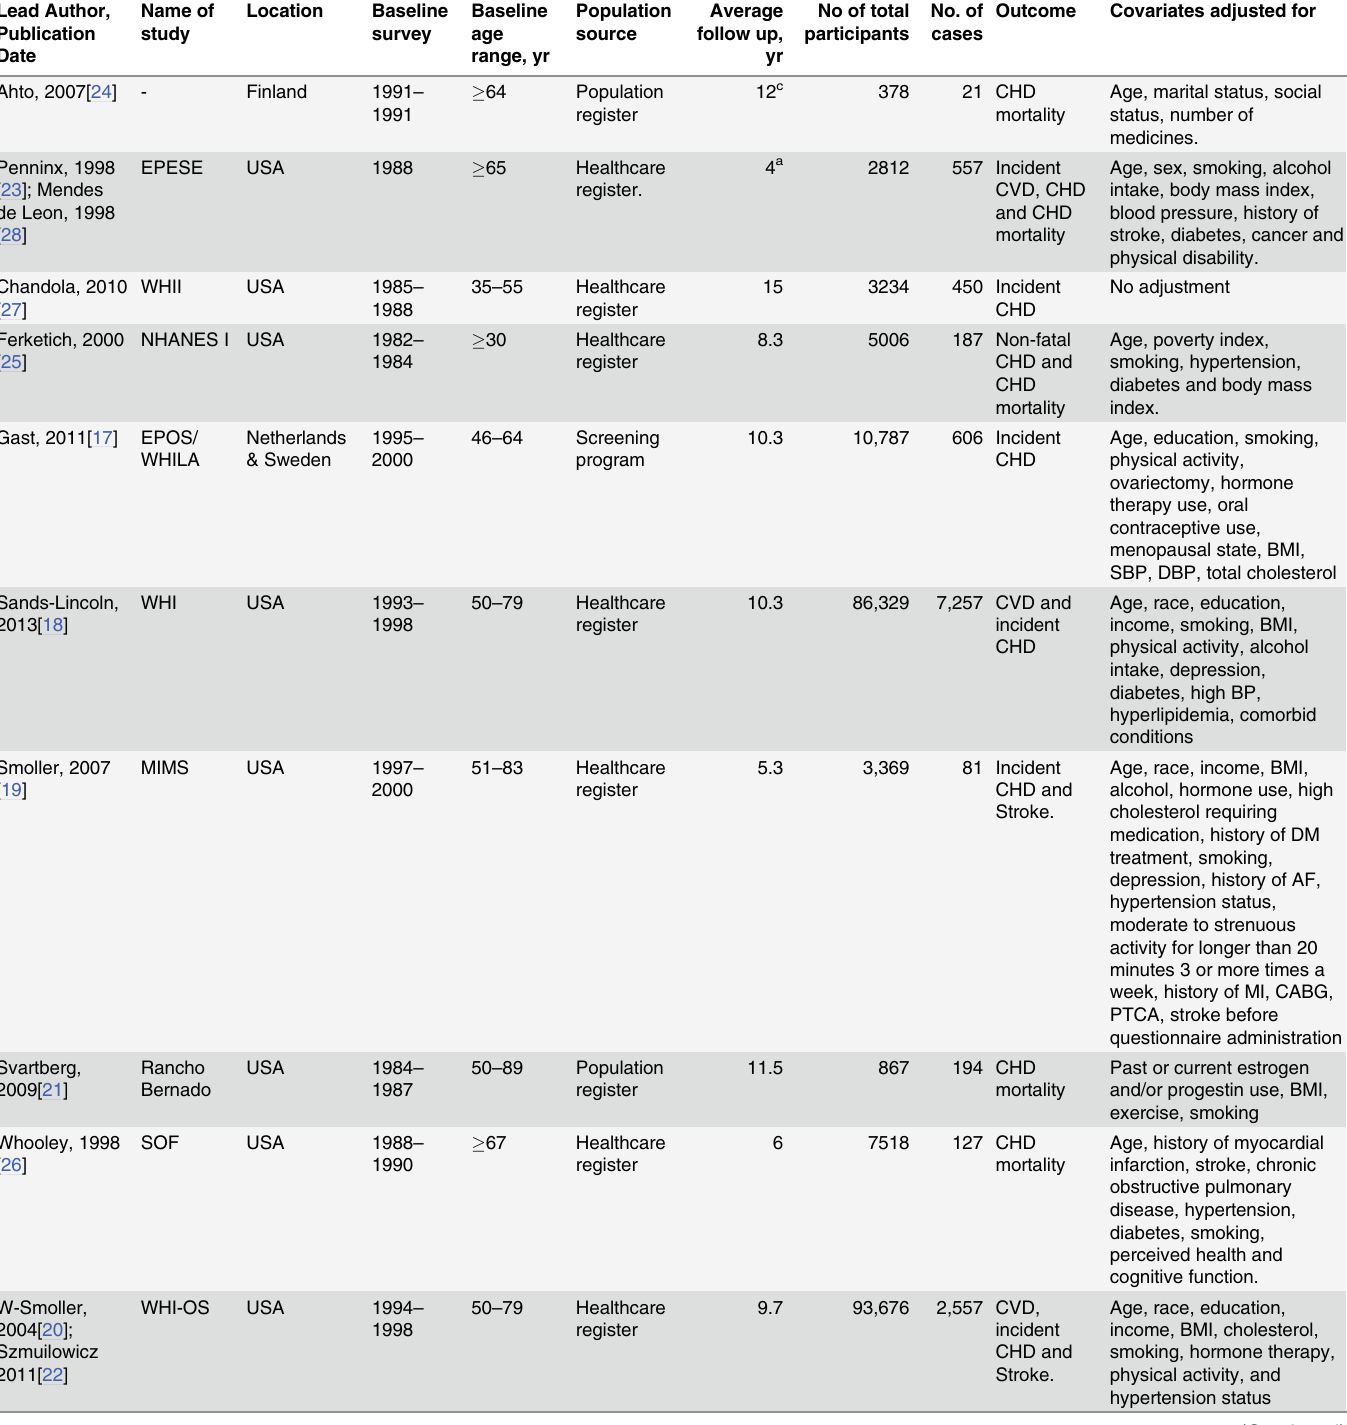
Table 1. General characteristics of prospective studies of cardiovascular disease outcomes included in